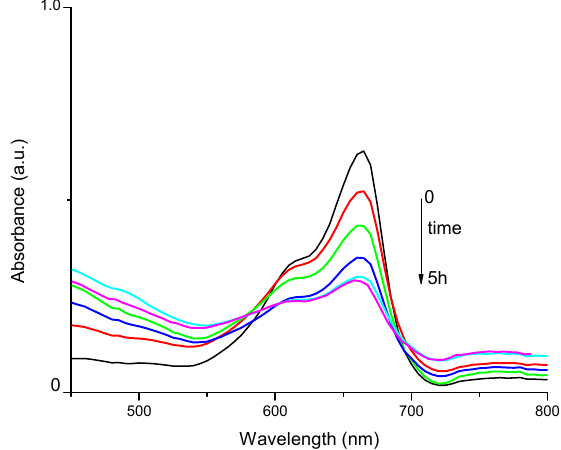
Figure 10. UV–vis spectra of the reduction reaction of MB by the in situ H 2 generated from water photoreduction.